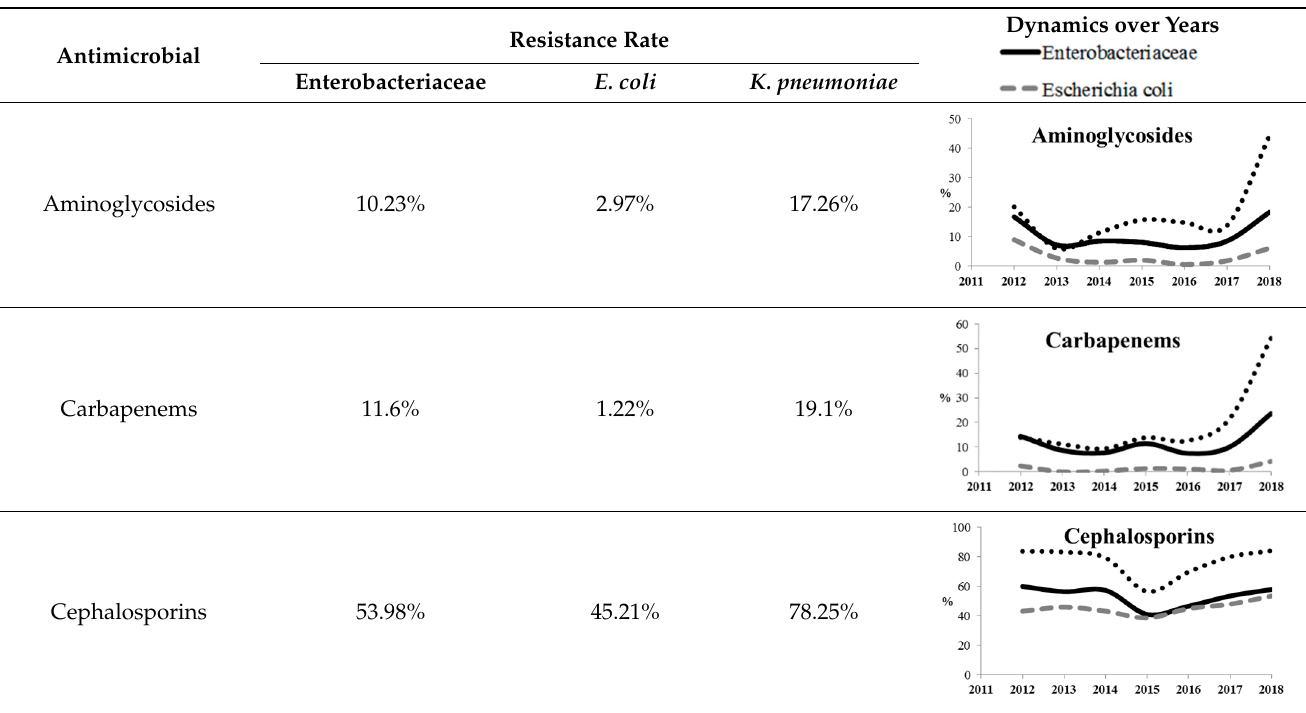
Table 4. Cumulative percentages of Enterobacteriaceae isolates inhibited by different concentrations of antimicrobials. The MIC 50 and MIC 90 values are shown in light gray and dark gray, respectively. Yellow, orange, red, and dark red cells indicated antibiotics with resistance level more than 30%, 40%, 50%, and 80%, respectively. Antimicrobial